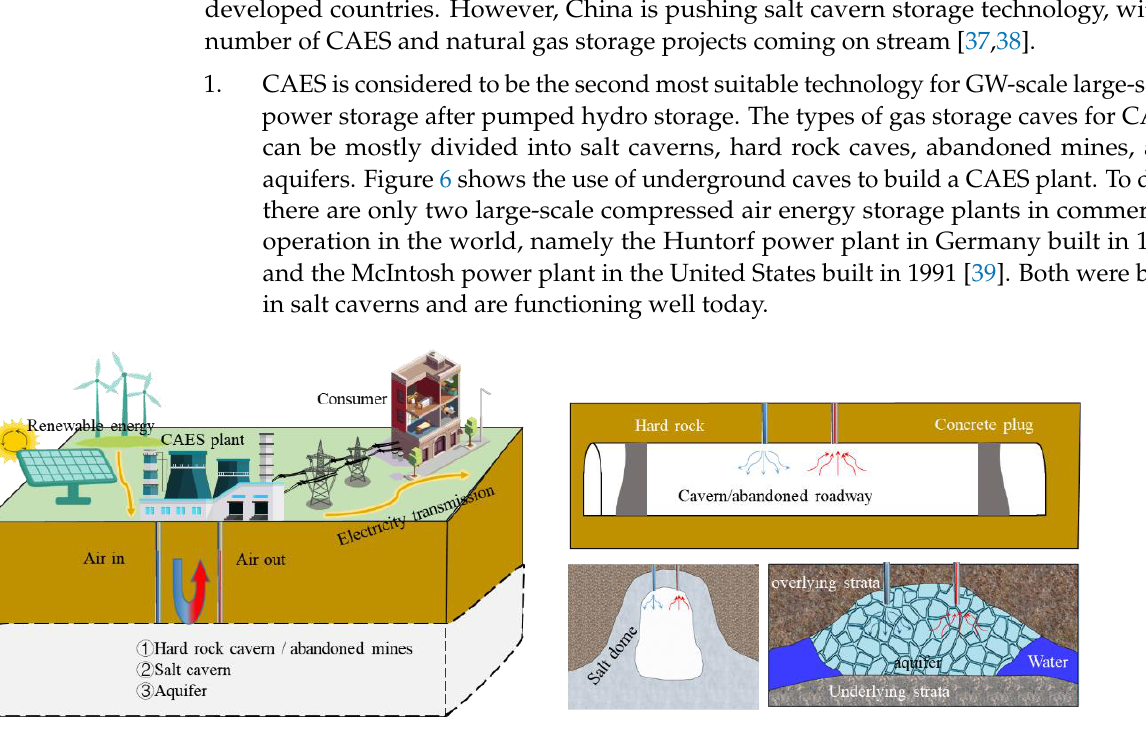
Figure 6. Construction of CAES plant using underground caves.